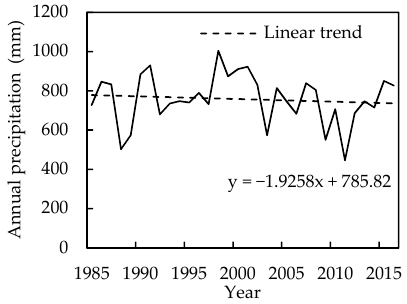
Figure 2. Variations in annual precipitation.